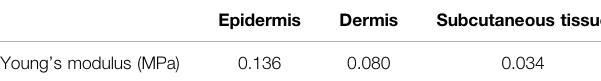
TABLE 1 | Physical parameters used in the fi nite element analysis.